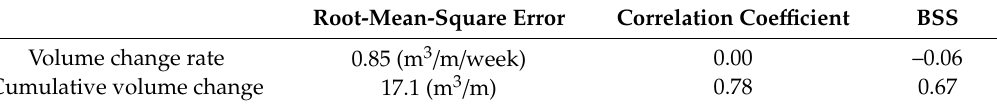
Table 2. The root-mean-square error, the correlation coe ffi cient, and BSS for the weekly averaged volume change rate and the cumulative volume change in the validation process.